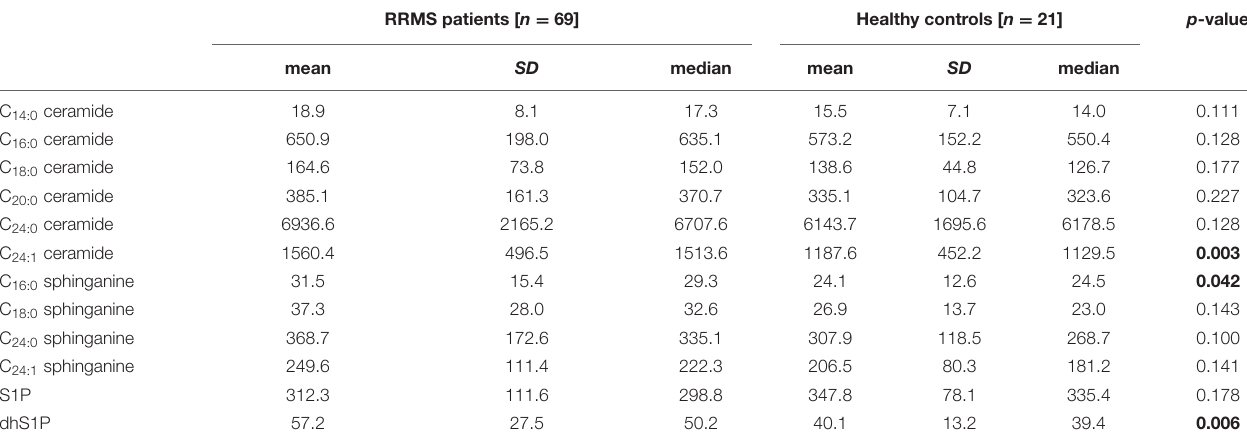
TABLE 3 | RRMS patients reveal a tendency of increased plasma ceramides compared to healthy controls. RRMS patients [ n = 69] Healthy controls [ n = 21]